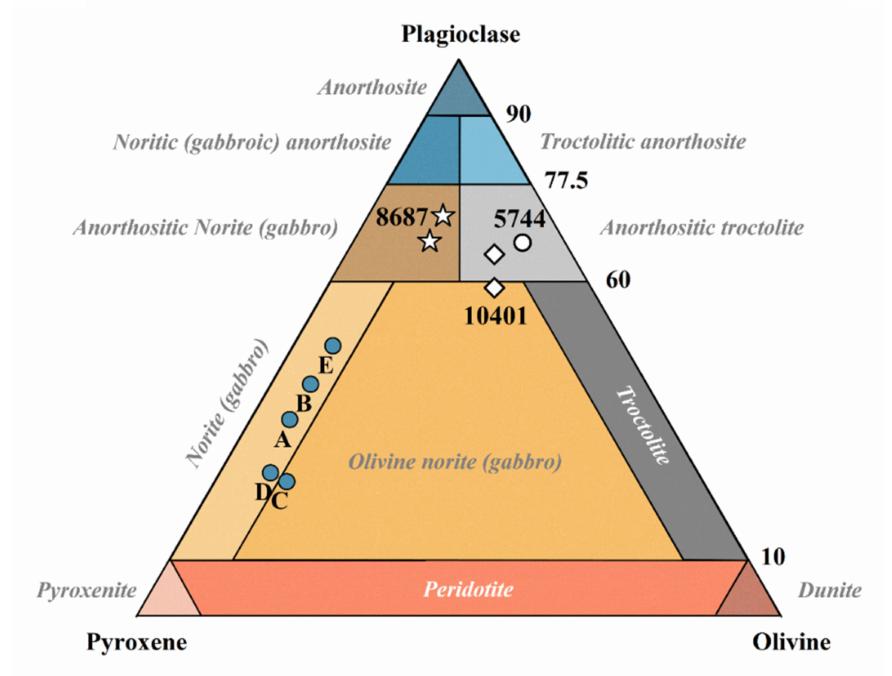
Figure 13. Classification of lunar meteorite NWA 8687 and comparison with pairs NWA 5744 and NWA 10401. Modal abundance (in vol.%) obtained by petrography (star) and by spectroscopy (blue circle) is expressed in the plot. This figure is modified from Figure 2 in Ref.